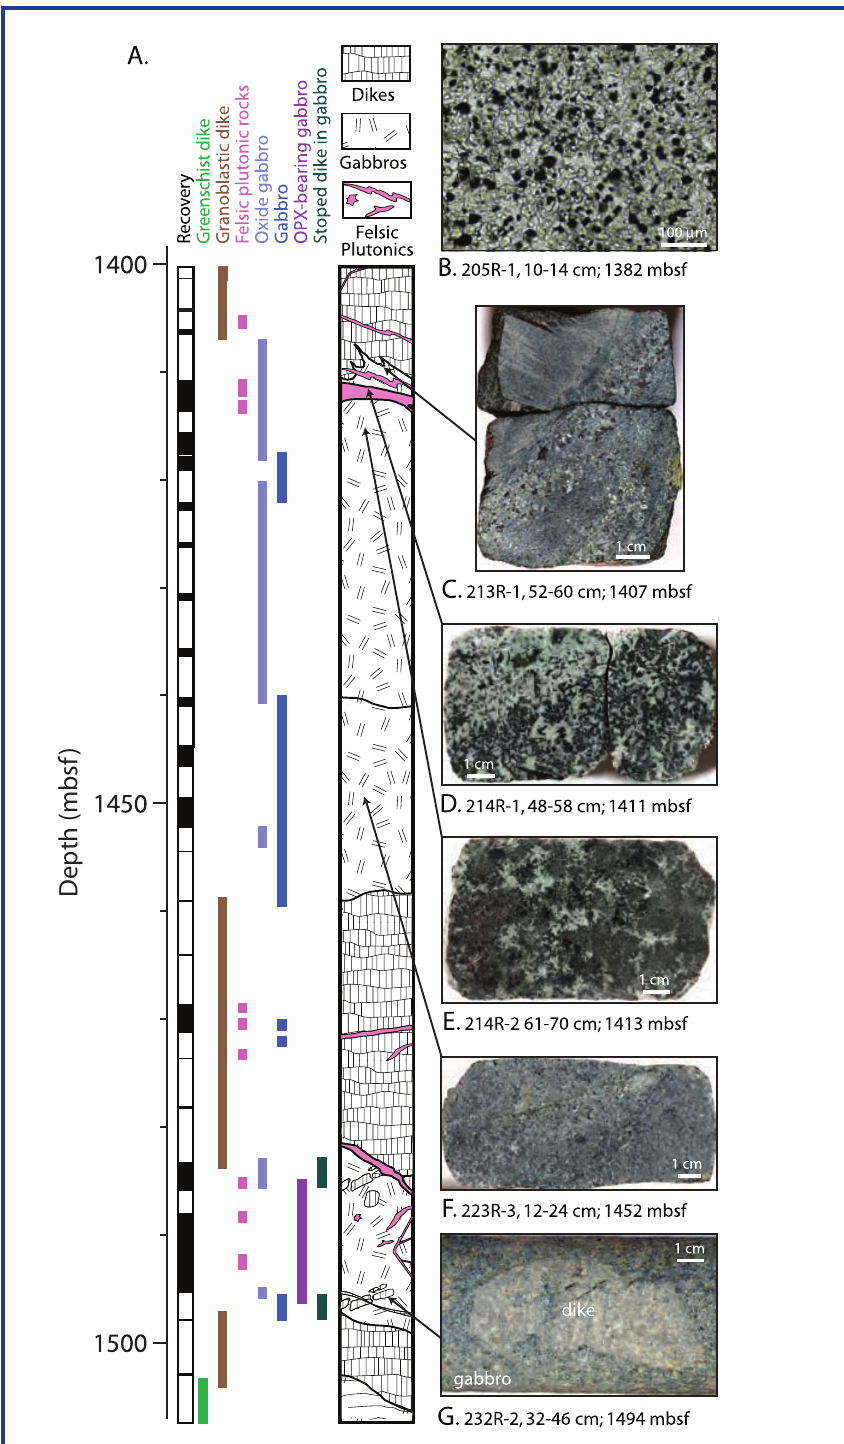
Figure 4. [A] Schematic lithostratigraphic section of the plutonic complex from the lower portion of Hole 1256D with representative photographs of key samples. The distribution of rock types is expanded proportionately in zones of incomplete recovery. Felsic plutonic rocks include quartz-rich oxide diorite and trondjhemite. [B] Photomicrograph of a dike completely recrystallized to a granoblastic association of equant secondary plagioclase, clinopyroxene, magnetite, and ilmenite. Some granoblastic dikes have minor orthopyroxene. [C] The dike-gabbro boundary! Medium-grained oxide gabbro is intruded into granoblastically recrystallized dike along an irregular moderately dipping contact. The gabbro is strongly hydrothermally altered. [D] Quartz-rich oxide diorite strongly altered to actinolitic hornblende, secondary plagioclase, epidote, and chlorite. Epidote occurs in ~5-mm clots in the finer grained leucocratic portions of the rock. [E] Disseminated oxide gabbro with patchy texture and cm-scale dark ophitically intergrown clinopyroxene and plagioclase patches separated by irregular, more highly altered leucocratic zones. [F] Medium-grained strongly hydrothermally altered gabbro. The sample is cut by several chlorite and actinolite veins with light gray halos. Plagioclase is replaced by secondary plagioclase and clinopyroxene by amphibole. [G] Clast of partially resorbed dike within gabbro. (photos from Wilson et